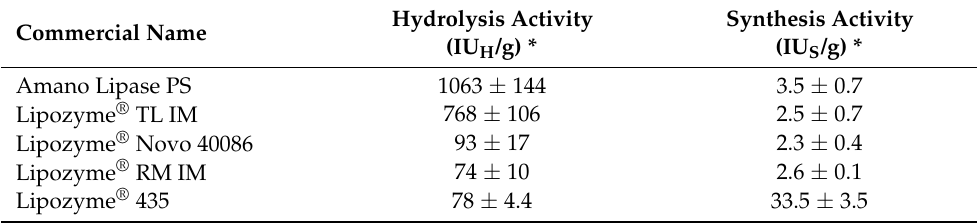
Table 1. Hydrolysis and synthesis activity of commercial immobilized